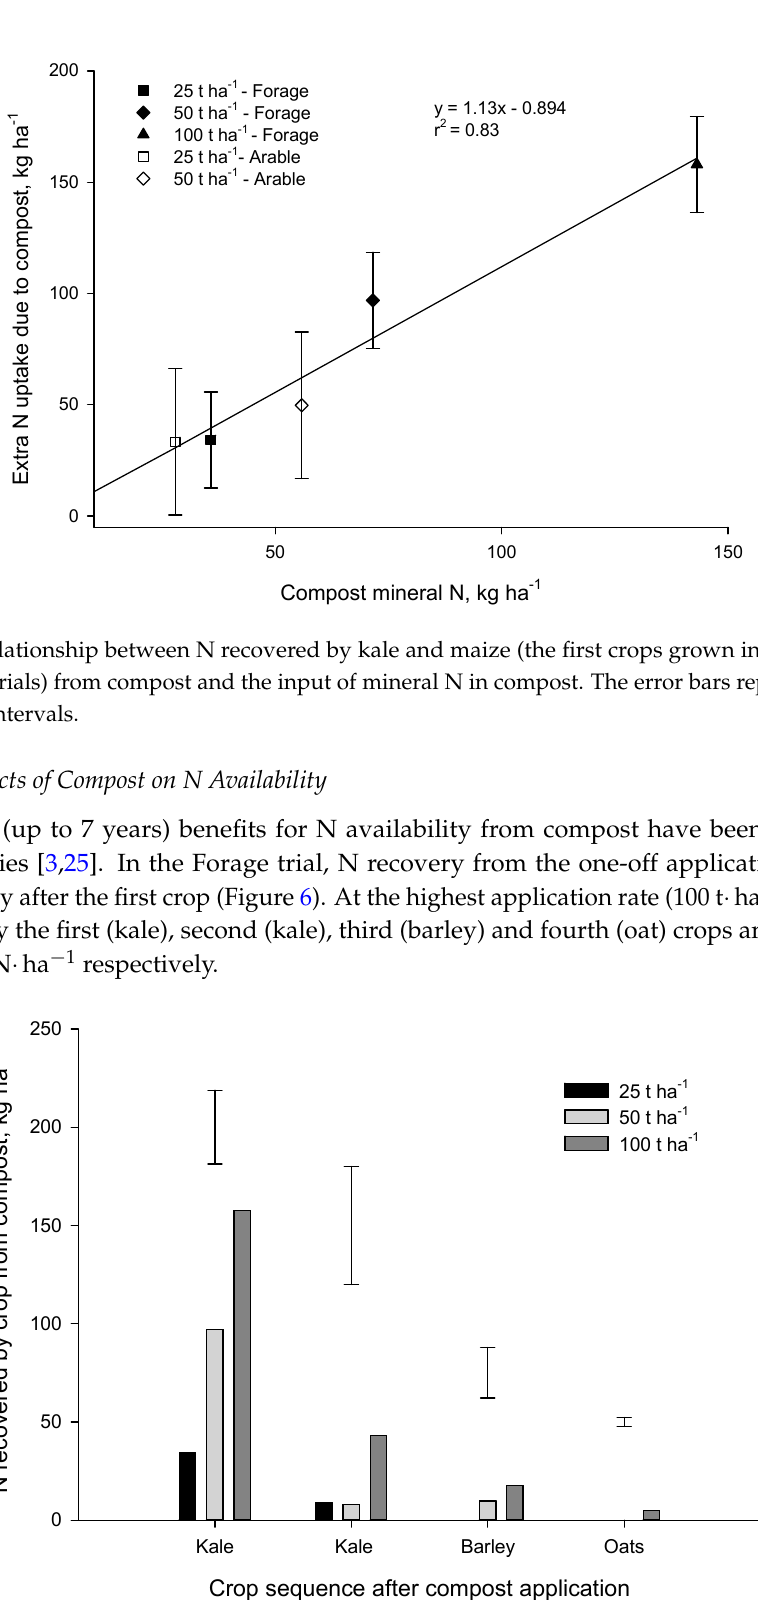
Figure 6. N recovered by crops grown in the Forage trial after a one-off application of either 25, 50 or 100 t·ha − 1 compost. Bars represent 5% LSD with 12 df . Nitrogen recovery from compost was calculated by subtracting crop N uptake without compost (control) from uptake in compost-treated plots.